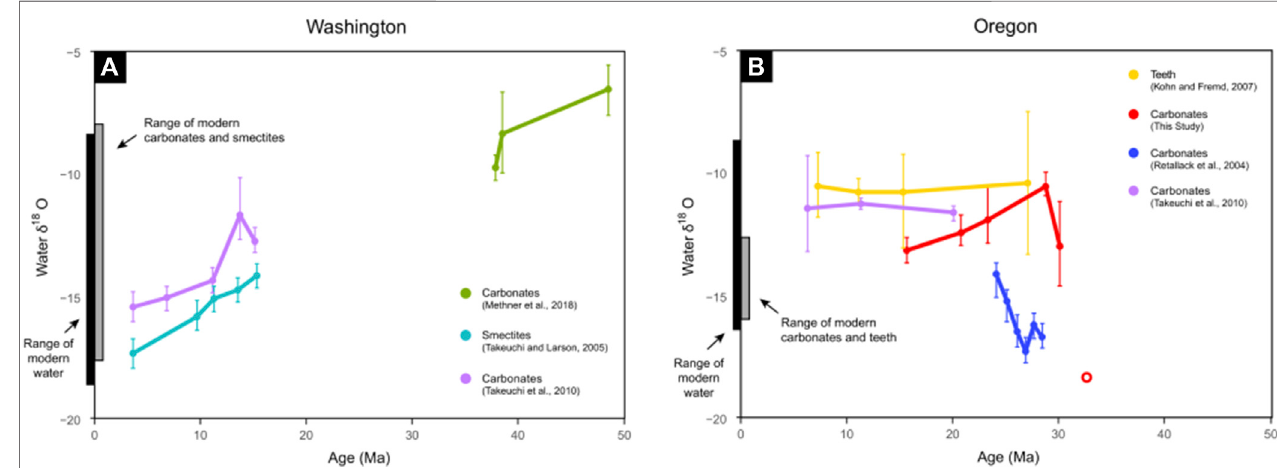
FIGURE 2 | Plots showing temporal variations in meteoric water based on δ 18 O values of carbonates, smectites, and fossil teeth for central Washington at ∼ 47 latitude (A) and central Oregon at ∼ 45 latitude (B) , both in the lee (east side) of the Cascade Mountains. Sample δ 18 O values are averaged within 2.5 million-year windows(shownaspoints)toemphasizetrendsacrossgeologictime.Uncertaintybarsrepresenttherangeof δ 18 Ovaluesfoundwithineachtime-window.Samplesare grouped (color-coded) by publication and sample type. The range of modern meteoric water δ 18 O east of the Cascade Mountains is shown (black bar) for both Washington and Oregon based on published stream data ( Table S2 ). Ranges in published modern carbonates east of the Cascade Mountains (Takeuchi et al., 2010; Lechler et al., 2018and thisstudy), smectites (Takeuchi and Larson,2005),and mammal teeth (Kohn and Fremd,2007) δ 18 O data( Supplementary Table S1 ) arealso shown for each state (gray bar). The open red circle (Oregon) represents sample JDRL_02, interpreted to be diagenetic carbonate.